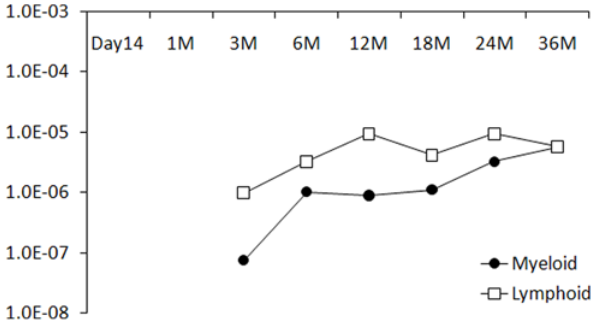
Figure 4. QPCR by Taqman probe measuring the contribution of RIS in near the MDS1/EVI1 TSS. X-axis denotes time points after transplantation; M, month(s). Y-axis denotes the % of level of integrated vector. Up to 3 months, the clone was undetectable.